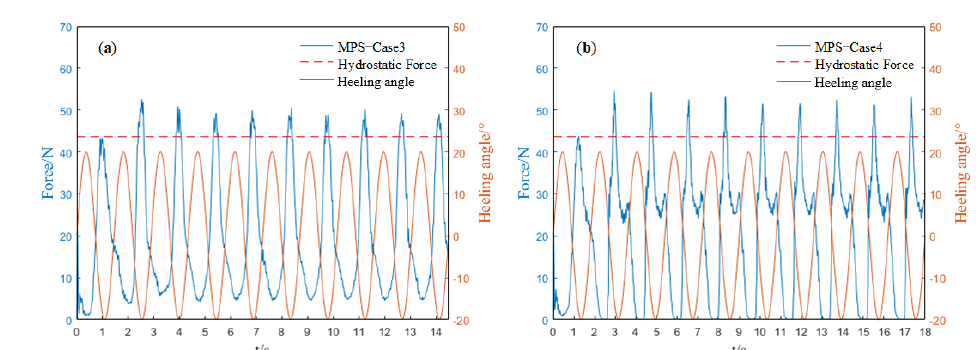
Figure 12. Comparison of dynamic force at two rolling periods in case 3 and case 4. ( a ) case 3; ( b ) case